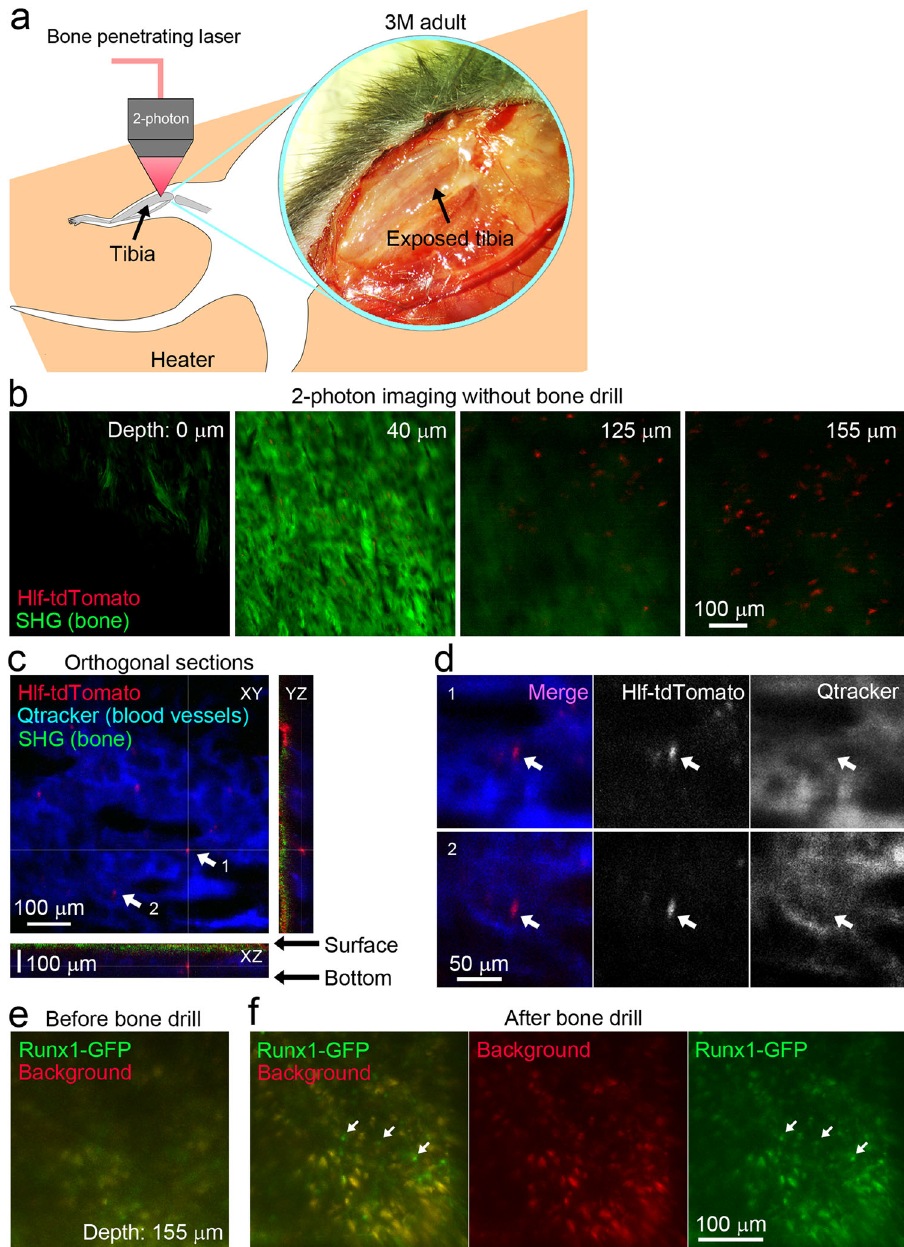
Fig. 2 Intravital two-photon imaging of Hlf-tdTomato-labeled cells in tibial bone marrow. a Experimental schema of intravital imaging of the tibial bone. The tibial bone was exposed, and the bone marrow was imaged without bone drilling using a high-powered infrared laser. b Z-stack images obtained via in vivo imaging of the bone marrow in the undrilled tibia of Hlf-tdTomato KI mice. Hlf-tdTomato-positive cells were observed in the bone marrow cavity. Bone surface, bone, and bone marrow cavities. The depth is indicated in the upper right corner of each panel. SHG, second harmonic generation. c Orthogonal view of 3D images con fi rmed that Hlf-tdTomato-positive cells were in the bone marrow under the tibial bone. Blood capillaries in the tibial bone marrow were visualized by intravenous injection of Qtracker 655. Cells indicated with arrows 1 and 2 are shown in higher magni fi cation in ( d ). See also Supplementary Movie 2. d Higher magni fi cation images of Hlf-tdTomato-positive cells located around the bone marrow capillary. e Intravital imaging of a Runx1-GFP mouse before drilling. Depth is 155 μ m from the bone surface. f Intravital imaging of the Runx1-GFP mouse after drilling. The same region in ( d ) was reimaged after drilling. Background signals were imaged in the red channel, suggesting that most signals in the green channel were arti fi cial backgrounds. Arrows indicate Runx1-GFP cells that had no background signals in the red three-dimensional time-lapse imaging of the bone marrow was performed in the undrilled tibia in neonates (postnatal day 2; Fig. 5a, left). The orthogonal view con fi rmed that the intravital imaging of the intact tibial bone marrow enabled the observation of endogenous tdTomato-positive cells in neonatal Hlf-tdTomato KI mice (Fig. 5a, right; Supplementary Movie 4). Quantitative